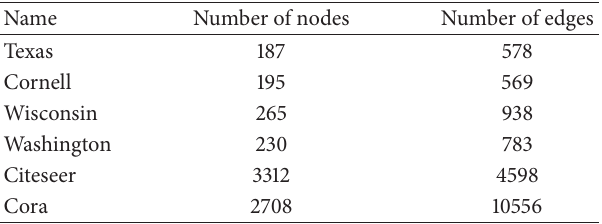
Algorithm 1: The classification algorithm based on class propagat- ing distributions. Table 1: The information about experimental